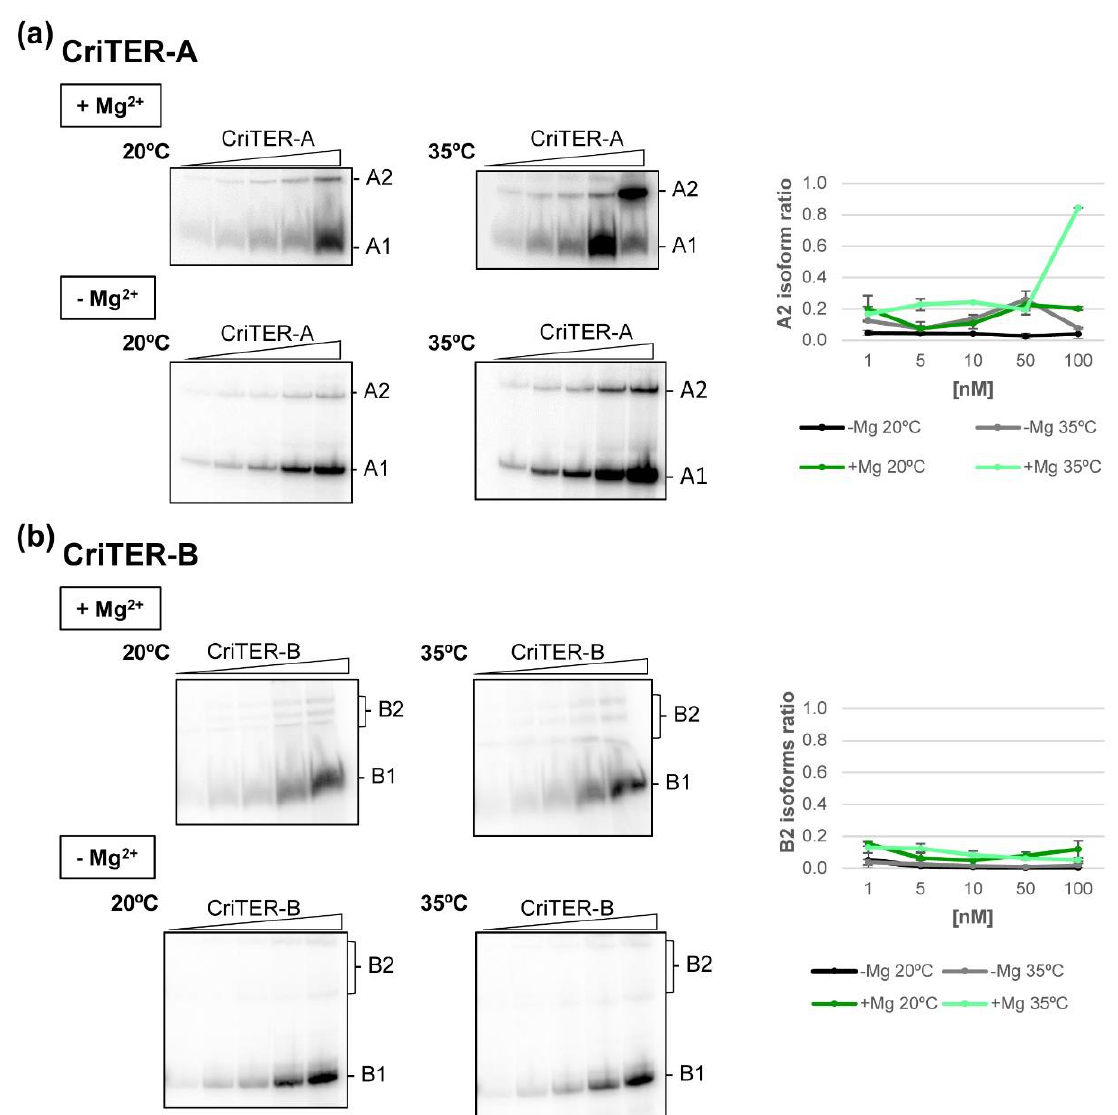
Figure 4. Conformational heterogeneity of CriTER-A and CriTER-B telomeric RNAs. Autoradiography of representative native polyacrylamide gels resolving increasing concentrations of CriTER-A ( a ) and CriTER-B ( b ) RNAs at basal temperature (20 ◦ C) and under heat sock conditions (35 ◦ C) in the presence (+) and absence ( − ) of 1 mM Mg 2+ . A quantification of the representative gels is shown at the right of the figure. A1 and A2 denote the two conformers of the CriTER-A RNA. B1 and B2 denote the two conformers of the CriTER-B RNA. Data represent the mean of three independent experiments.